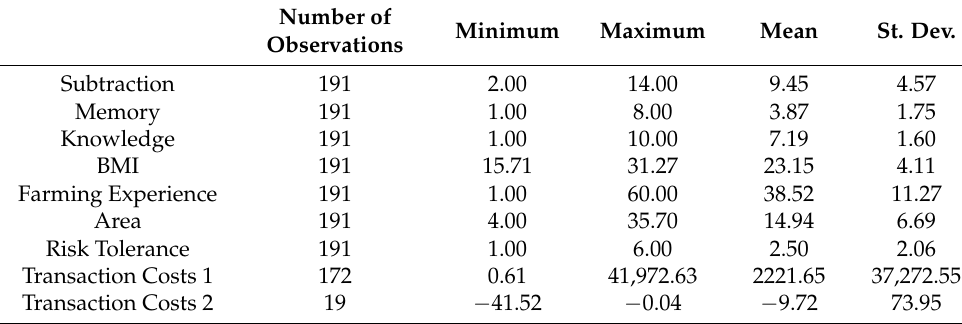
Table 3. Descriptive statistics of characteristic variables.